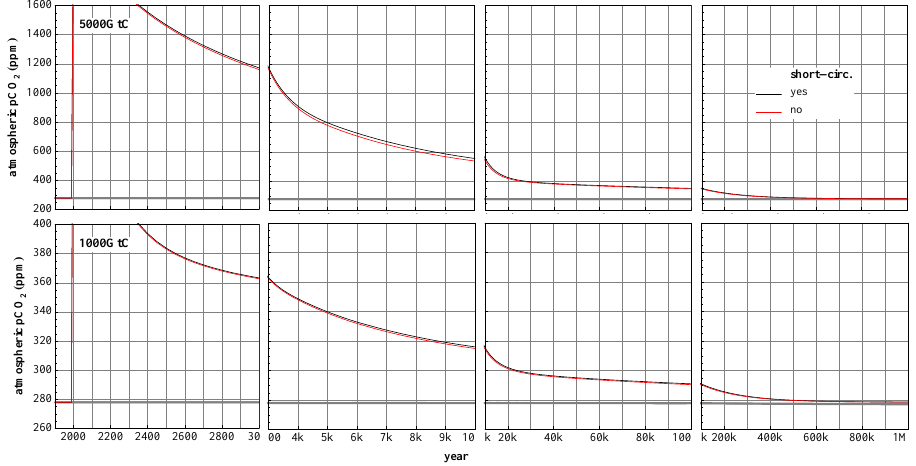
Fig. 4. Evolution of atmospheric CO 2 over 1 Myr for 1000 GtC (bottom) and 5000 GtC (top) emissions pulses, vs. a control run with no emissions (grey lines at bottom of plots), with short-circuiting of the atmosphere on/off.